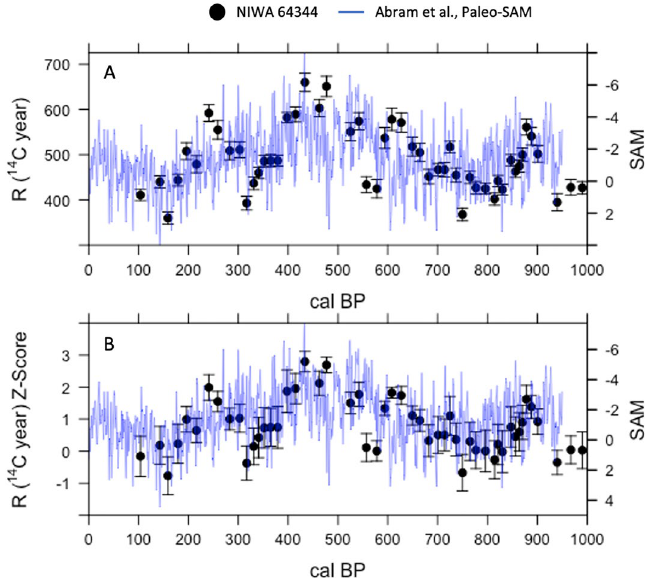
Figure 3. Subtropical SPG ∆R Variability and Paleo-SAM over the last Millennium. ( A ) A comparison of black coral ∆R values for the East Auckland Current (black dots—NIWA 64344) with the paleo-SAM index from Abram et al. 39 (blue line). ( B ) A comparison of ∆R normalized Z-scores (black dots) against Paleo-SAM (blue line). All uncertainties shown are 1σ, are calculated using the Soulet 62 methodology, and reflect the uncertainty in the radiocarbon age, U-Th calendar age, and the SHCal20 curve 61 .